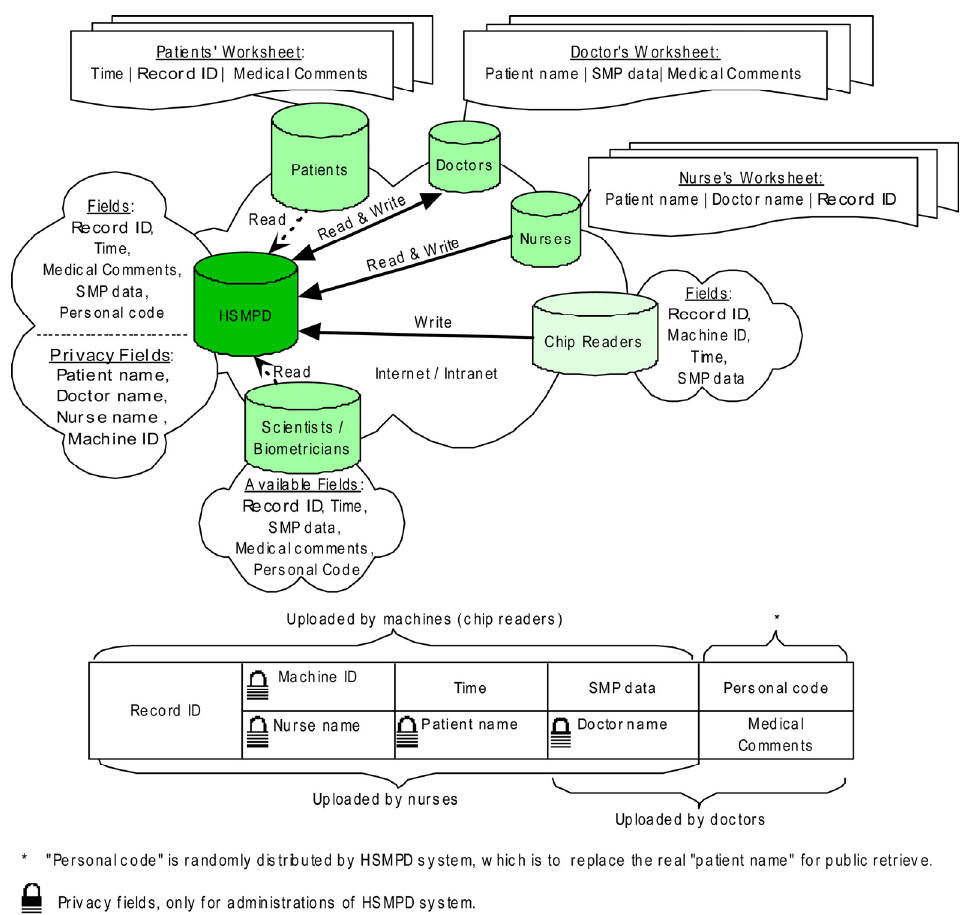
Figure 3. Data structure of HSMPD. Clinical records in HSMPD will be inputted by doctors, nurses and chip readers. The information of every record is categorized into two parts. The medical SMP data is open for all researchers and patients without unnecessary ethical review, whereas the private information of patients is protected behind firewall, which can be mediated by a trusted